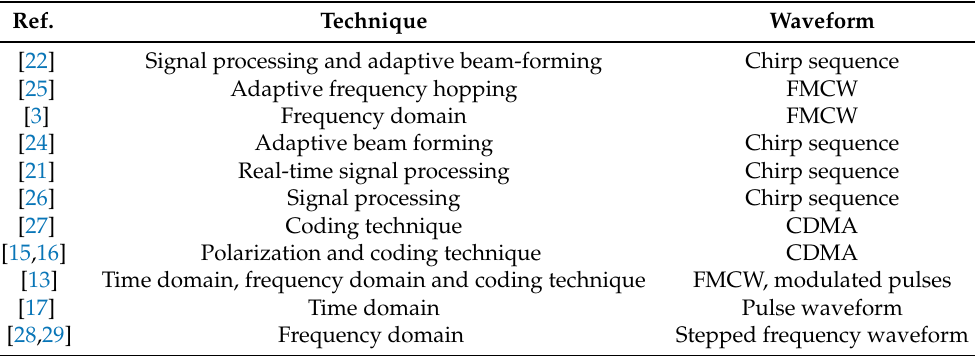
Table 1. Literature